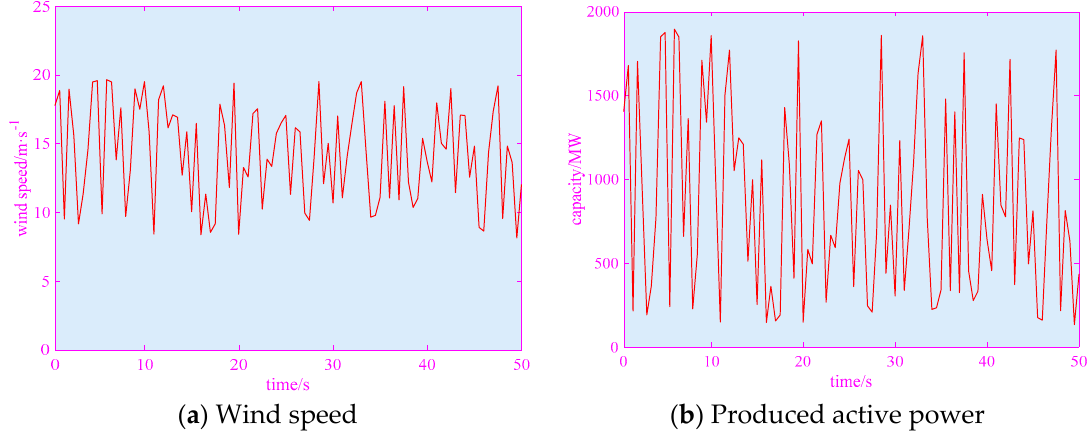
Figure 7. Wind speed and produced active power of the wind farm.